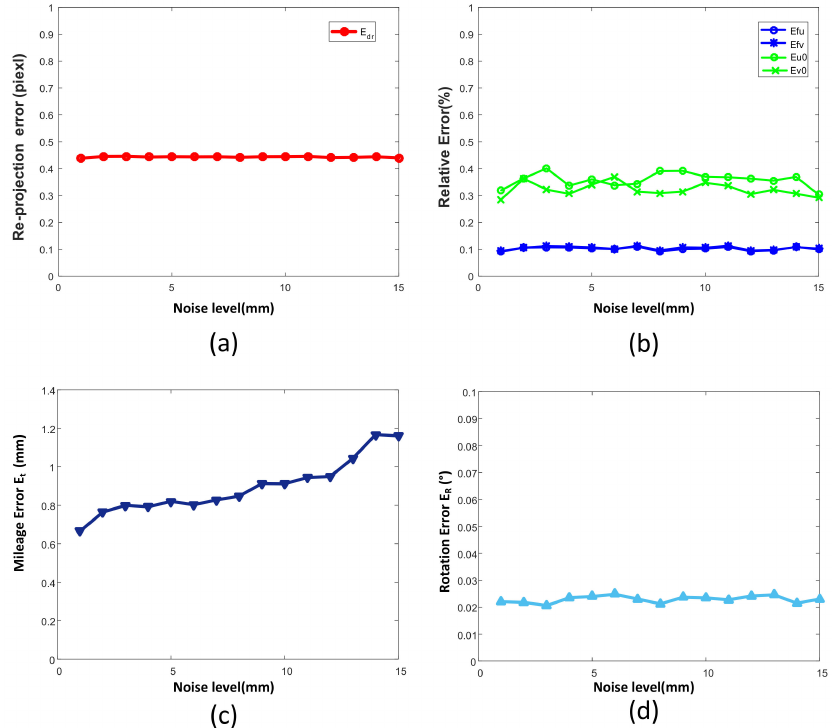
Figure 6. Simulation results of different distance noise levels. ( a ) Re-projection error E dr ; ( b ) Effects of noise on intrinsic parameters such as E fu , E fv , E u 0 , E u 0 ; ( c ) Mileage error E t with different noise; ( d ) the effects of noise on rotation error E R .